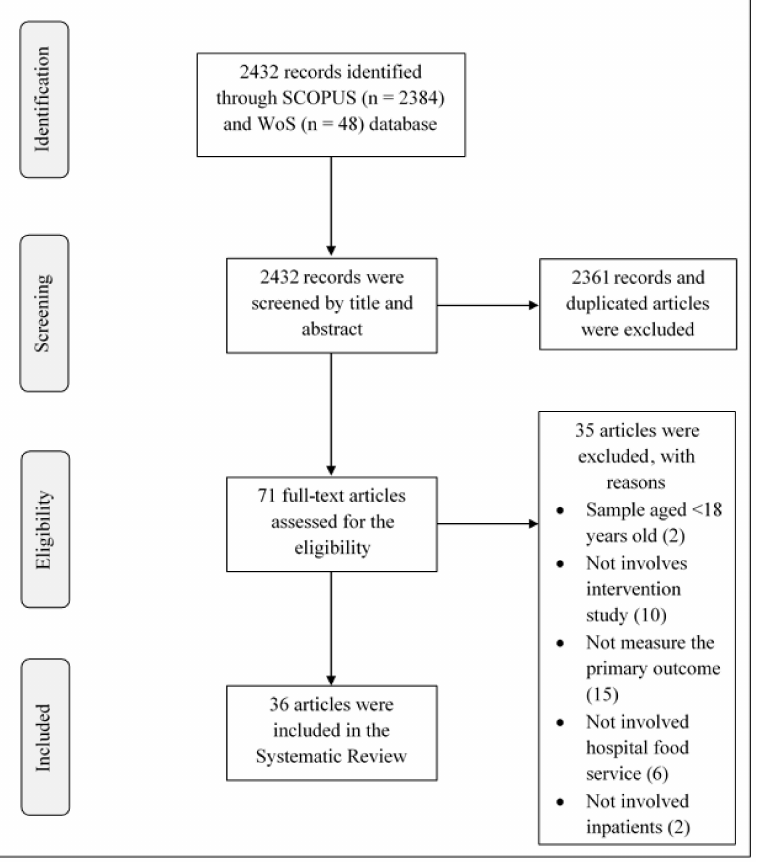
Figure 1. Flow chart for the literature search process. Table 2. Quality assessment using the Quality Criteria Checklist for Primary Research of the 36 included studies in a systematic review of hospital food